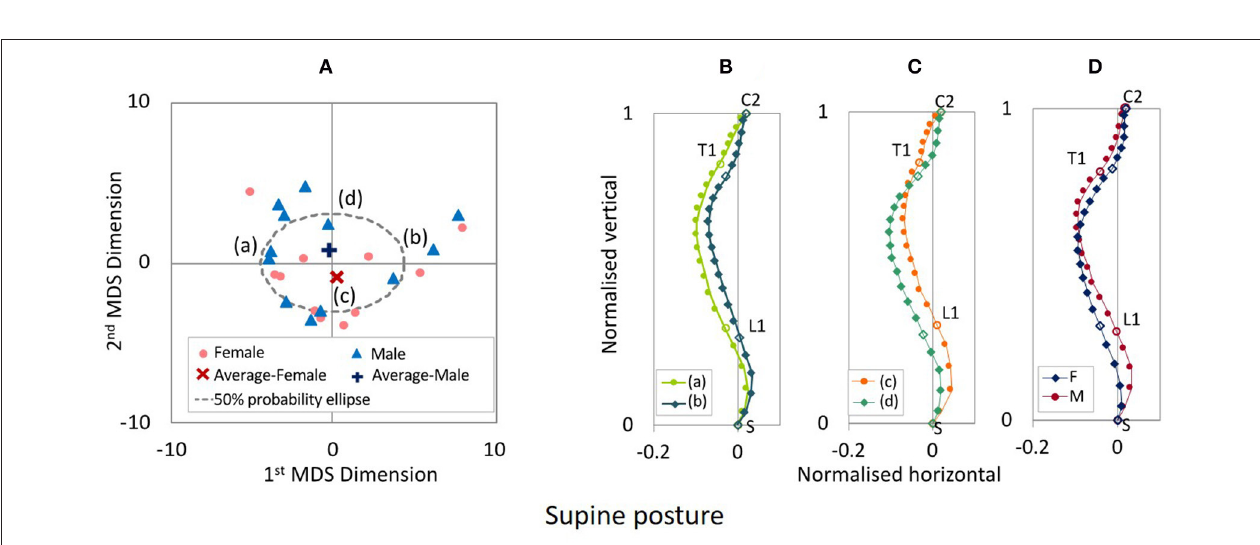
FIGURE 7 | (A) MDS distribution map of spinal alignments for the supine posture. (B) Spinal alignments estimated at the intersections of the 50% probability ellipse with the 1st MDS dimension (a,b) and (C) the 2nd MDS dimension (c,d), and (D) the female and the male average points (F and M).